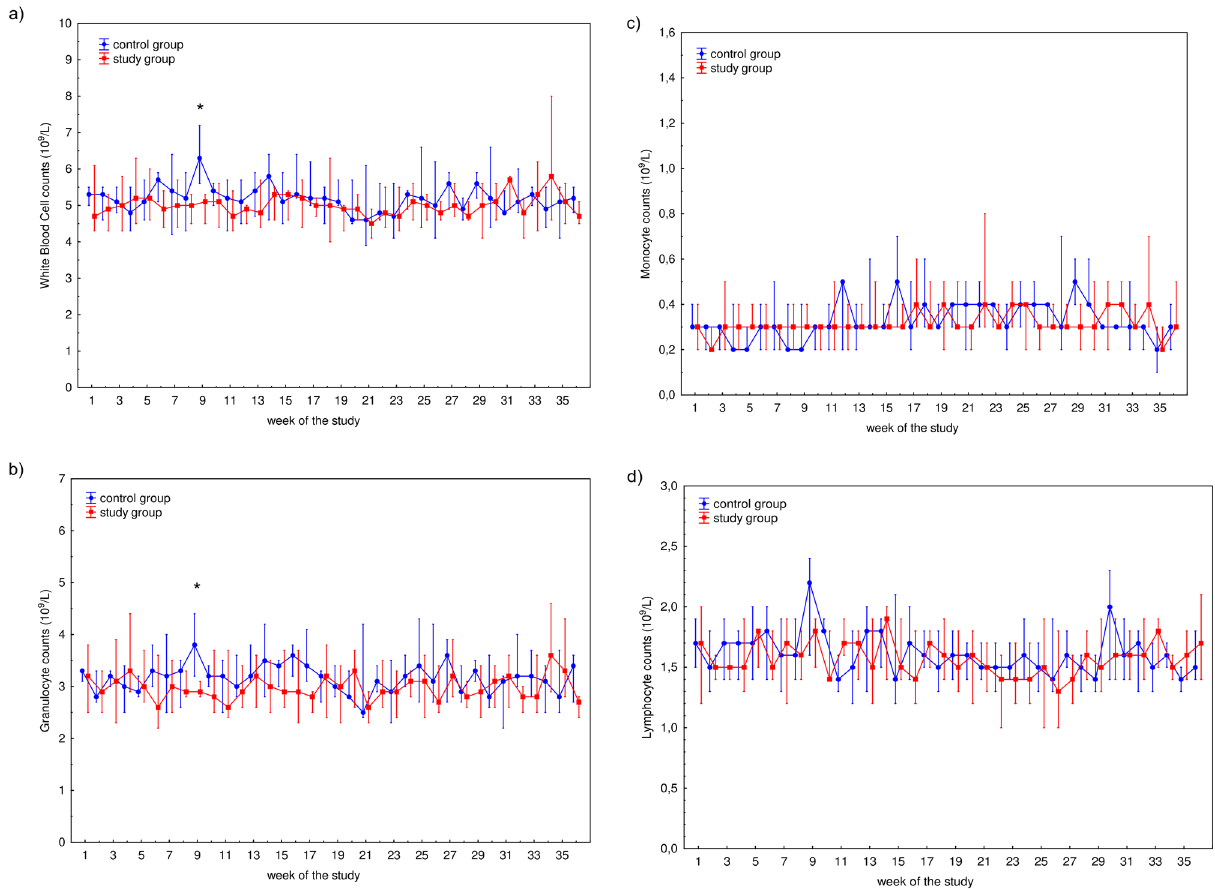
Figure 2. Median counts of: ( a ) white blood cells, ( b ) granulocytes, ( c ) monocytes, and ( d ) lymphocytes in studied participants’ blood measured during 36-week study among 22 professional soccer players. Blood morphology values were obtained using automatic analyzer ABX Micros 60. The midpoint represents median; whiskers represent Q1–Q3 range. The significance of differences between the control and study groups was calculated using the Mann–Whitney U test. P value < 0.05 was considered to be significant. * P <